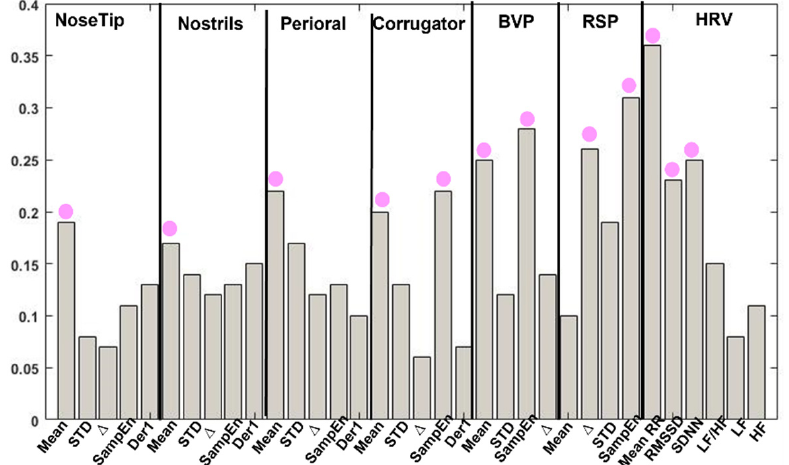
Figure 7. First FeedForward Neural Network layer’s weights. The red dots represent the features associated with the highest weights for each physiological signal.